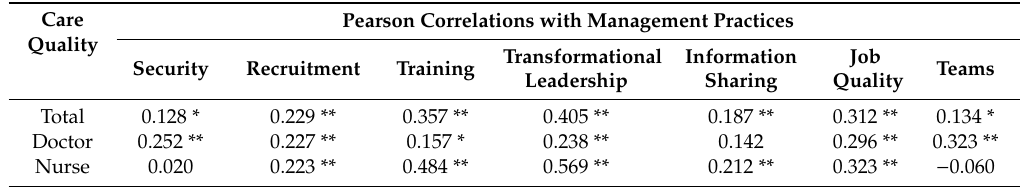
Table 3. Correlations between management practices and patient care outcomes. Care